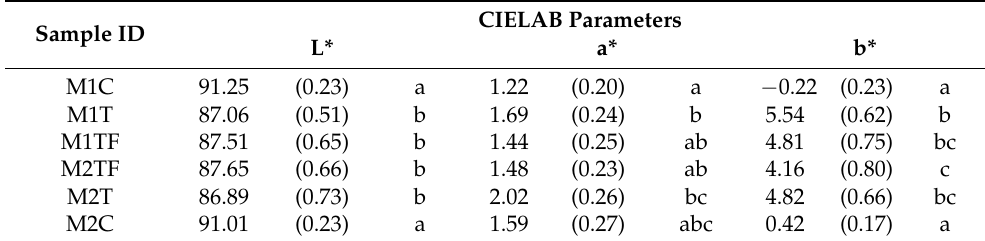
Table 4. Final values of the L*, a* and b* CIELAB parameters of the experimental